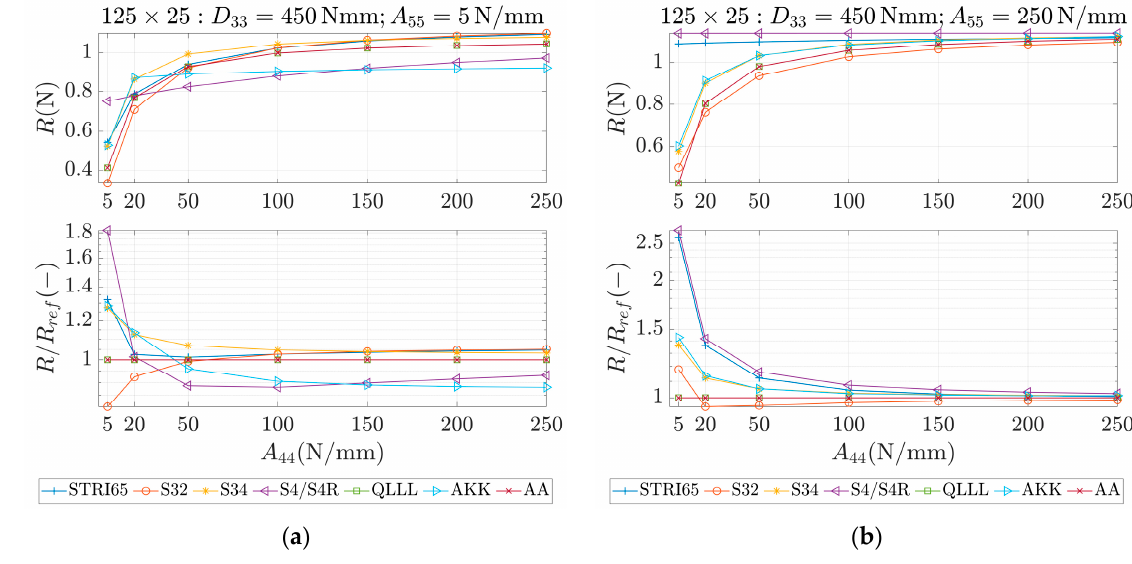
Figure 8. Reactions (first row) and reactions to the reference (analytical) solution (second row) for 75 × 75 sample, D 33 = 900 Nmm and di ff erent values of A 44 . ( a ) A 55 = 5 N / mm and ( b ) A 55 = 250 N / mm.